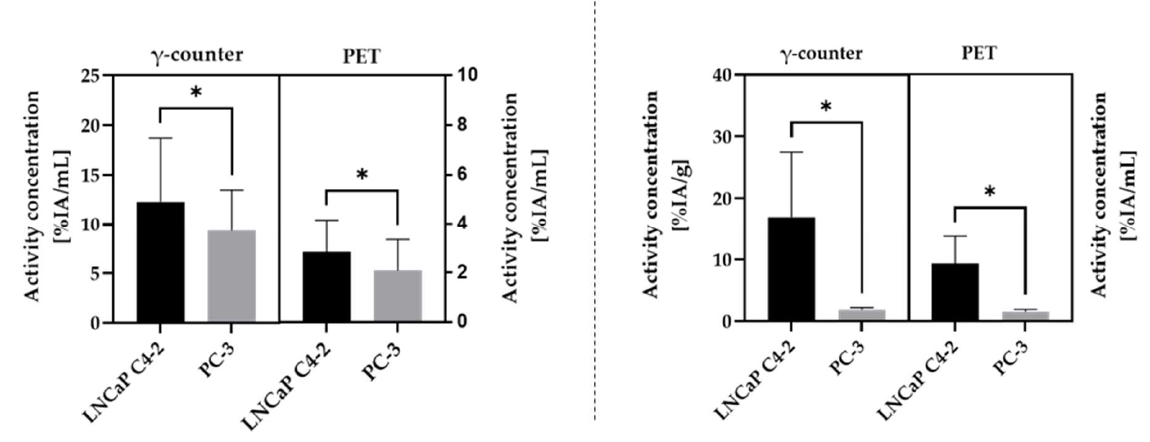
Figure 4. Comparison of chick embryo ( left diagram ) and mouse model ( right diagram ) using two different evaluation methods ( γ -counter and PET-based data). A significantly higher activity concentration (*, p < 0.05) in the PSMA + tumor xenograft LNCaP C4-2 is demonstrated regarding PSMA − PC-3 for both evaluation methods and in both in vivo models. Significance was tested by Wilcoxon matched-pairs signed rank